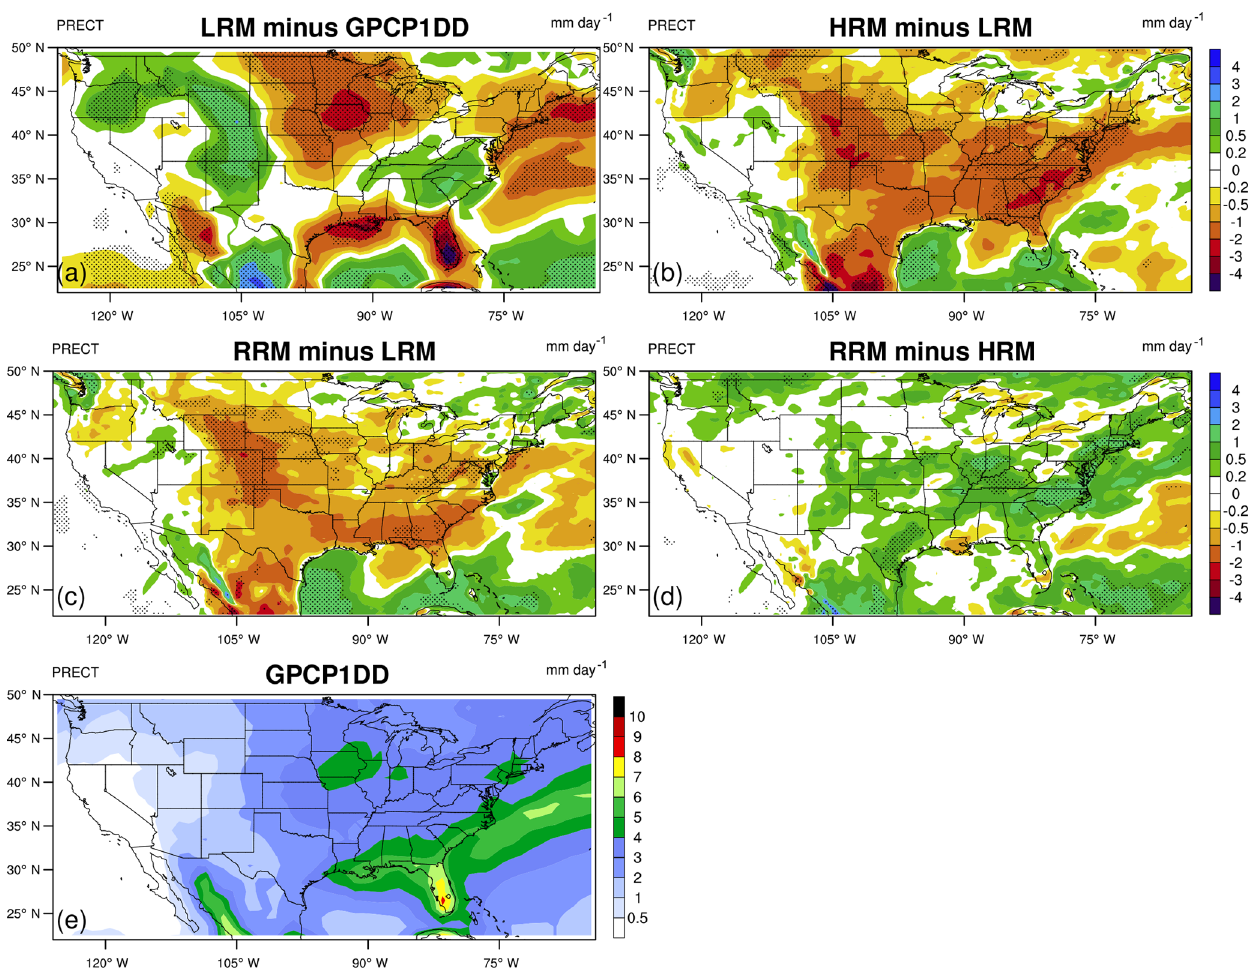
Figure 4. Mean differences of total precipitation (unit: mmd − 1 ) in JJA for (a) LRM minus GPCP1DD data, (b) HRM minus LRM, (c) RRM minus LRM, (d) RRM minus HRM, and (e) GPCP1DD. The differences between the LRM and evaluation data (i.e., panel a ) are computed on the evaluation grid, while those between models (i.e., panels b – d ) are computed on the HRM grid. Dotted areas denote where the differences are statistically significant at the 95% confidence level with the two-tailed Student’s t